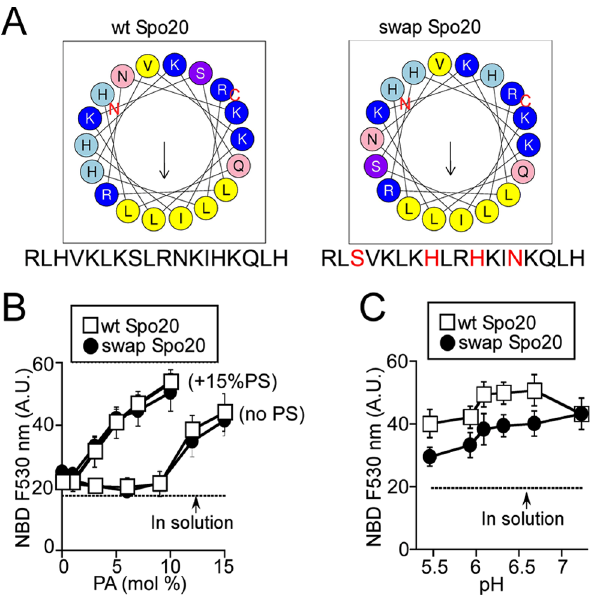
Figure 6. Membrane binding properties of the swap Spo20 mutant. ( A ) Helical wheel representations of the Spo20 sequence and of the corresponding swap mutant. ( B–C ) NBD fluorescence assays comparing the membrane partitioning of the [NBD]Spo20-GCC and [NBD]swapSpo20-GCC bioprobes (0.3 m M) to various liposomes (0.35 mM). In ( B ), the liposomes contained (mol %) PE (25), cholesterol (25), PS (0 or 15) and increasing amounts PA. The remaining lipid was PC. In ( C ), the liposomes contained (mol %) PC (25), PE (25), cholesterol (25), PA (10) and PS (15) and the partitioning of the constructs was tested at various pH. Data shown are mean ¡ S.E of 3 independent experiments. All liposomes were prepared by extrusion through 0.2 m m polycarbonate filters.